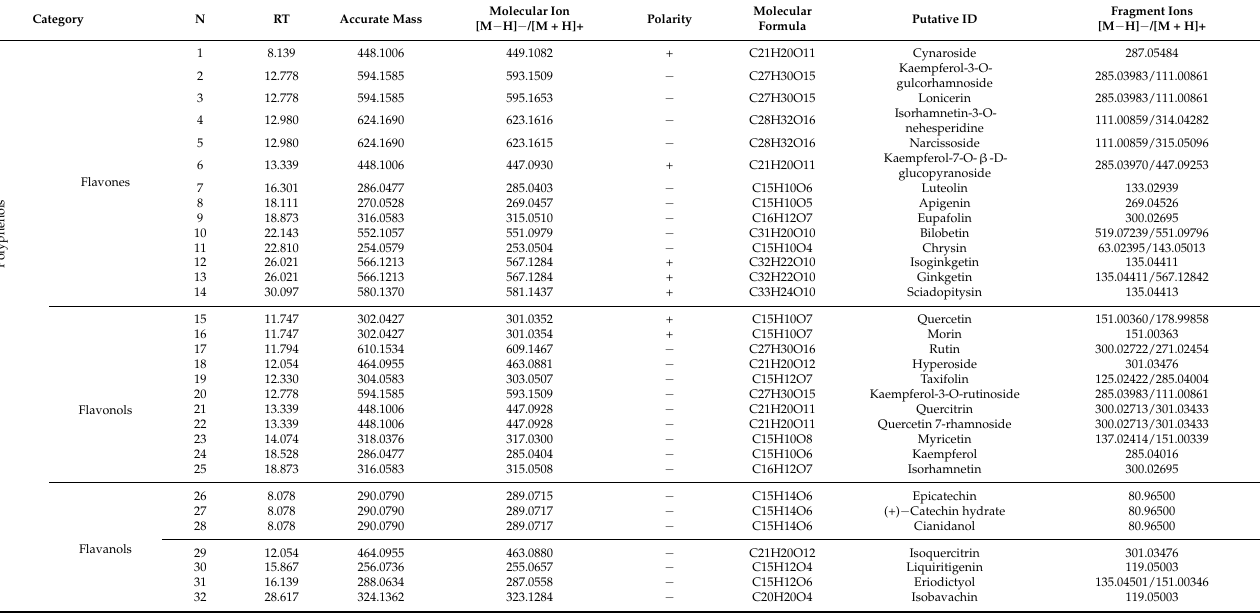
Table 2. The qualitative composition of